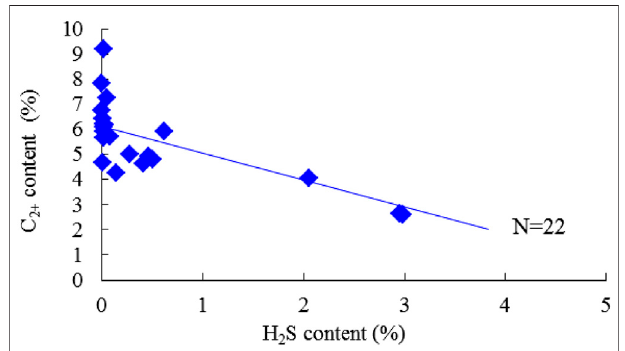
FIGURE 6 | Relationship between C 2+ and H 2 S content.